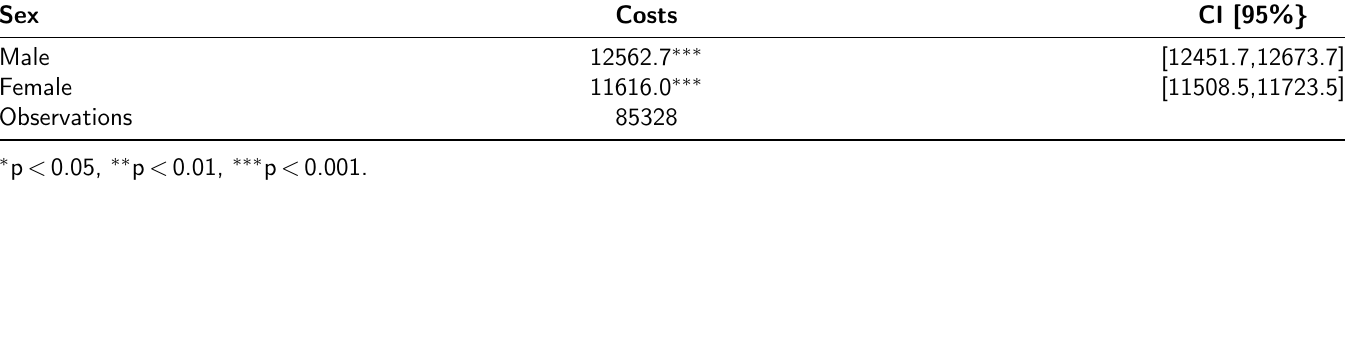
Supplementary Table 3: Univariate Analysis GLM - Age in categories